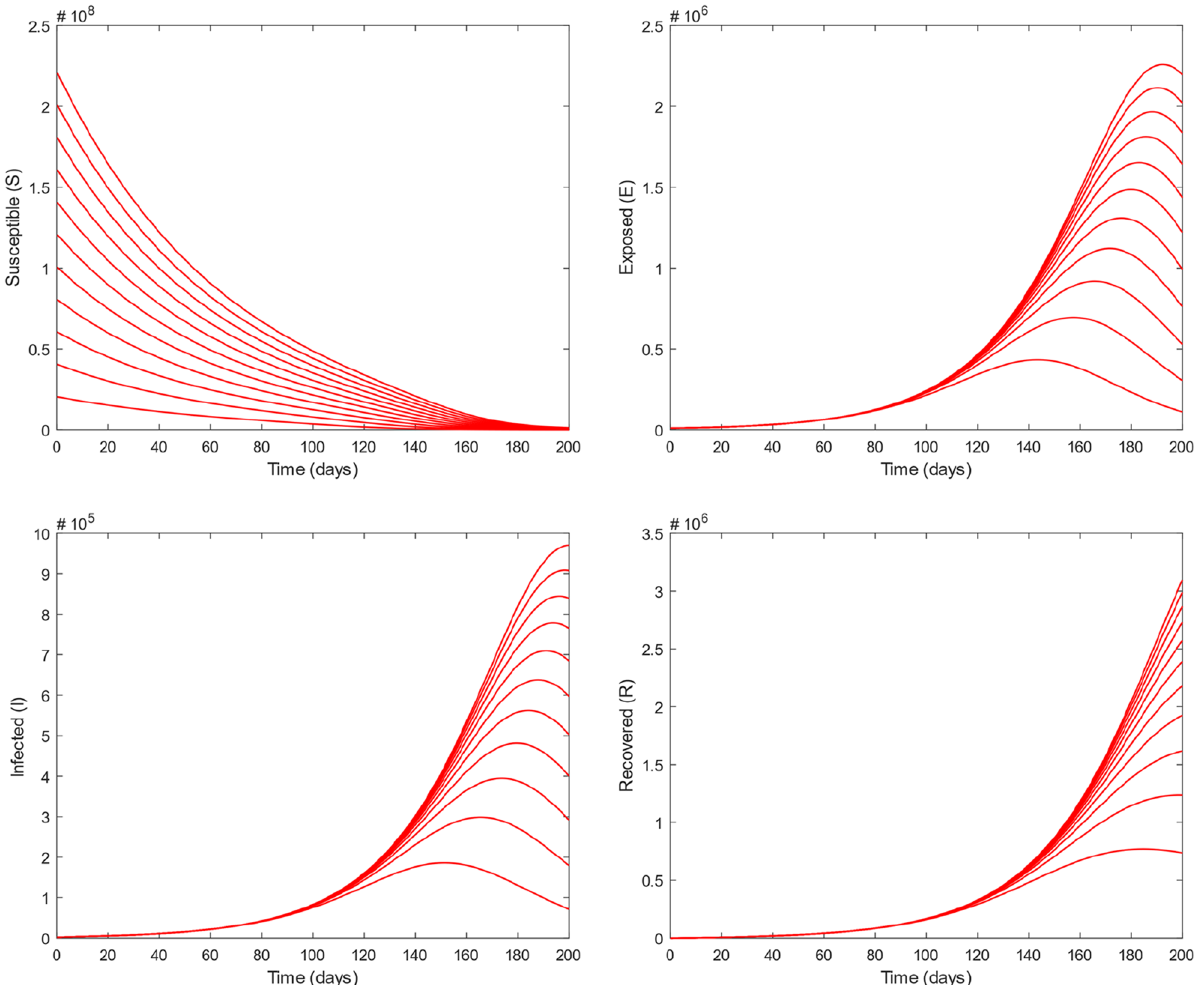
Figure 9. The dynamics of COVID-19 in different classes with different initial